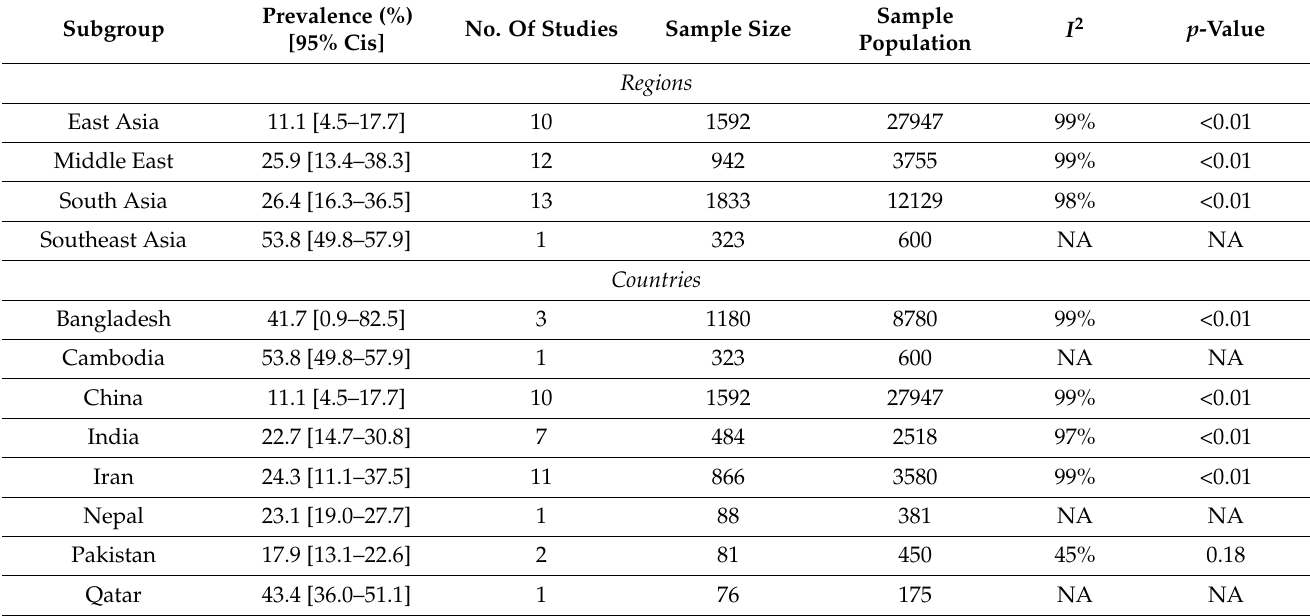
Table 2. Pooled prevalence of DEC in different Asian